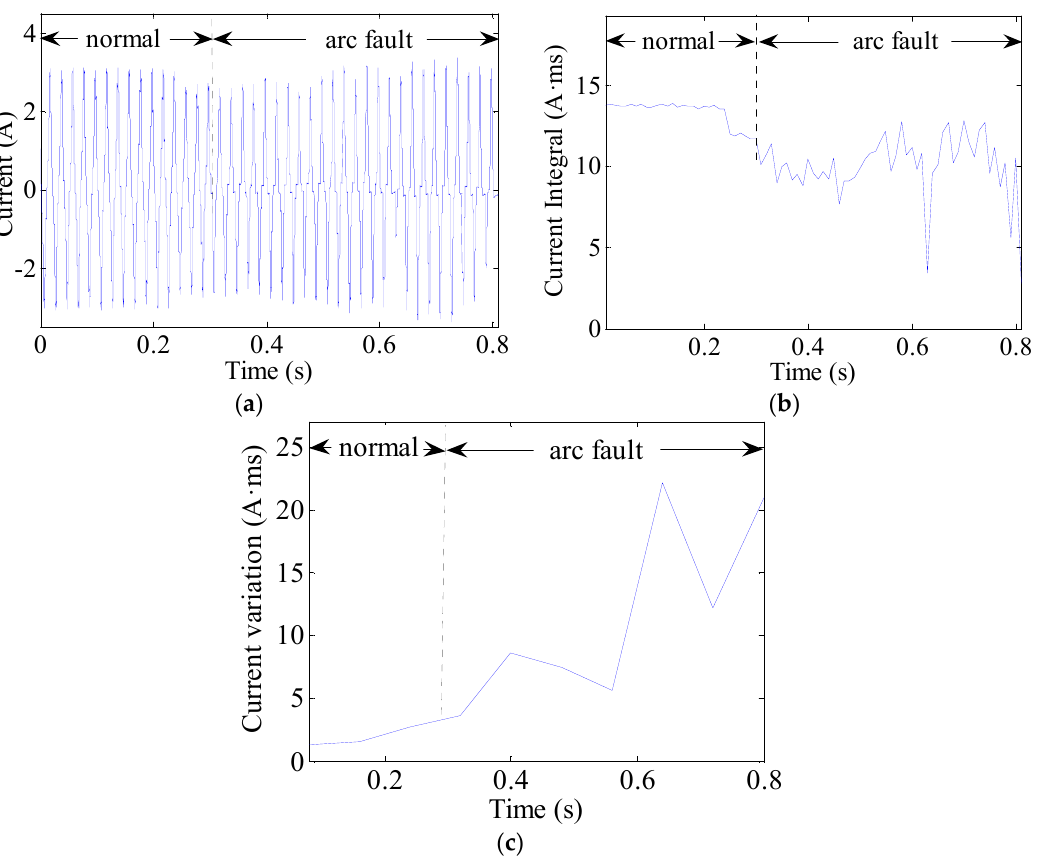
Figure 13. Arc fault current analysis of the electrical drill: ( a ) current waves; ( b ) current periodic integrals; ( c ) current variations.